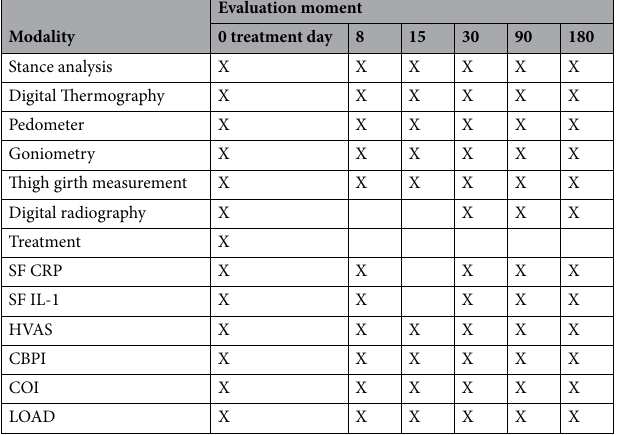
Table 5. Procedures conducted at each moment. Days are counted from treatment day. CBPI Canine Brief Pain Inventory, COI Canine Orthopedic Index, CRP C-Reactive Protein, HVAS Hudson Visual Analogue Scale, IL-1 Interleukin 1, LOAD Liverpool Osteoarthritis in Dogs, SF Synovial